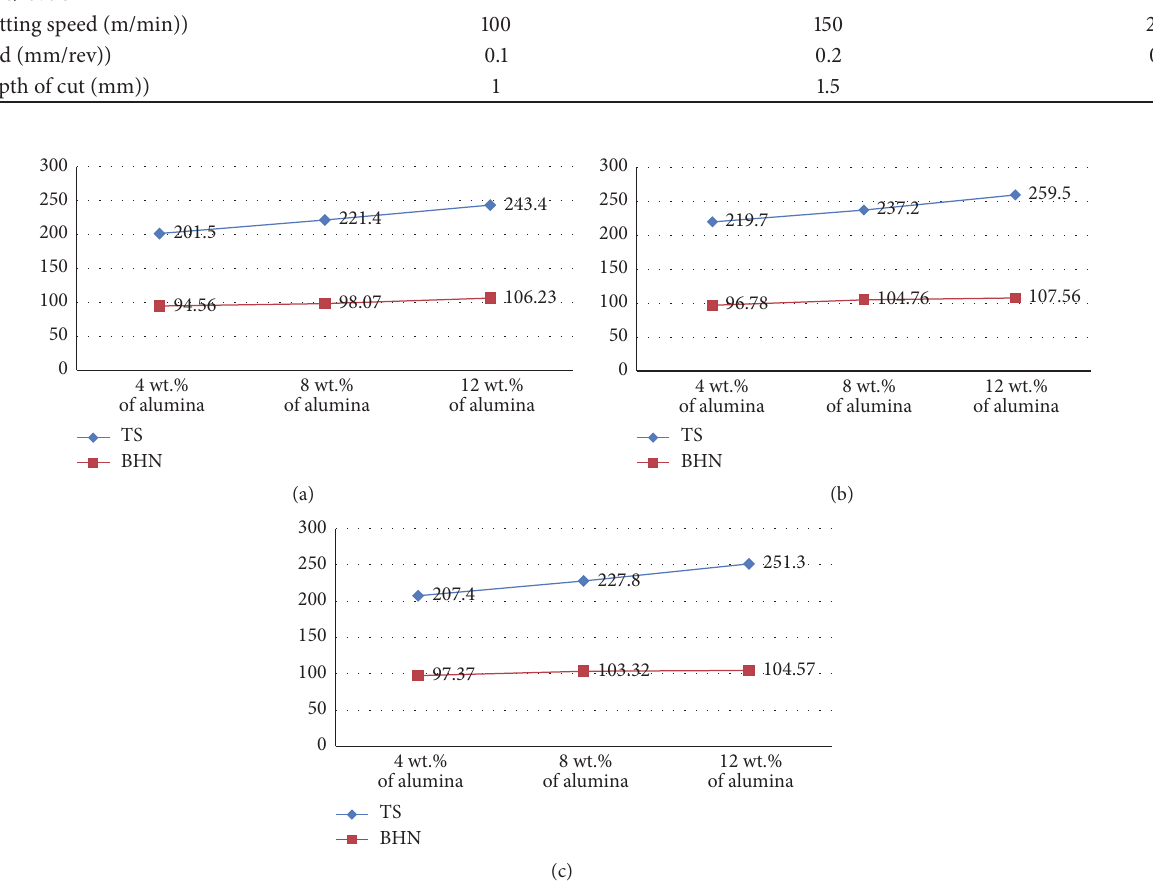
Figure 1: (a) Mechanical behaviour of Al6061/2 wt.% of MoS 2 /4:8:12wt.% of Al 2 O 3 . (b) Mechanical behaviour of Al6061/4 wt.% of MoS 2 /4:8:12wt.% of Al 2 O 3 . (c) Mechanical behaviour of Al6061/6 wt.% of MoS 2 /4:8:12wt.% of Al 2 O 3 .